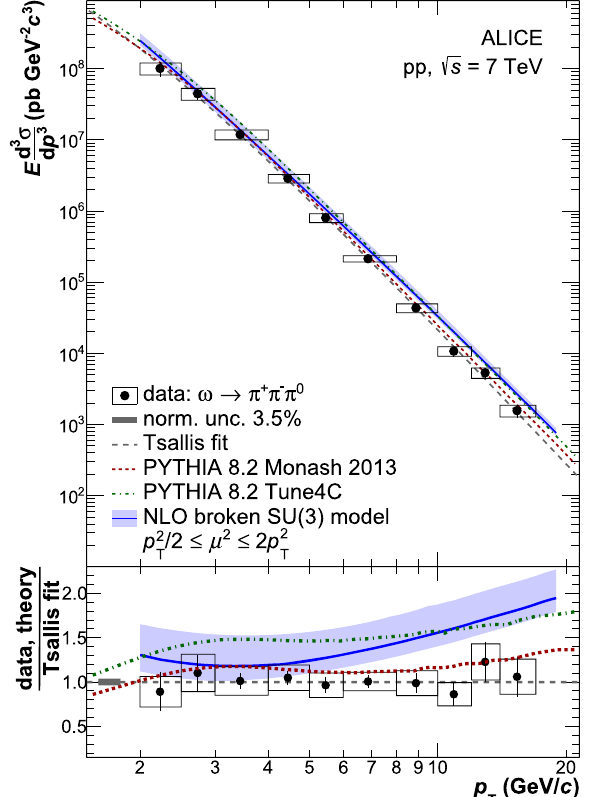
Fig. 3 Invariant cross section of ω meson production in pp collisions √ s = 7TeV compared to theoretical predictions. The statistical at and systematic uncertainties are represented by vertical bars and boxes, respectively. A Levy–Tsallis function was used to parametrise the spec- trum, where the obtained fit parameters are given inTable 2. The predic- tions are obtained using PYTHIA 8.2 [43] with the Monash 2013 [44] and 4C [45] tunes. Furthermore, a NLO calculation [14] incorporating a model dedicated to describe vector-meson fragmentation is shown, where the band denotes the uncertainty of the scale μ , which was usedforfactorisation,renormalisationandfragmentation.Inthebottom panel, the ratios of the theoretical estimates to the Levy–Tsallis fit of the measurement are shown; the ratio of the data to the Levy–Tsallis fit is also presented